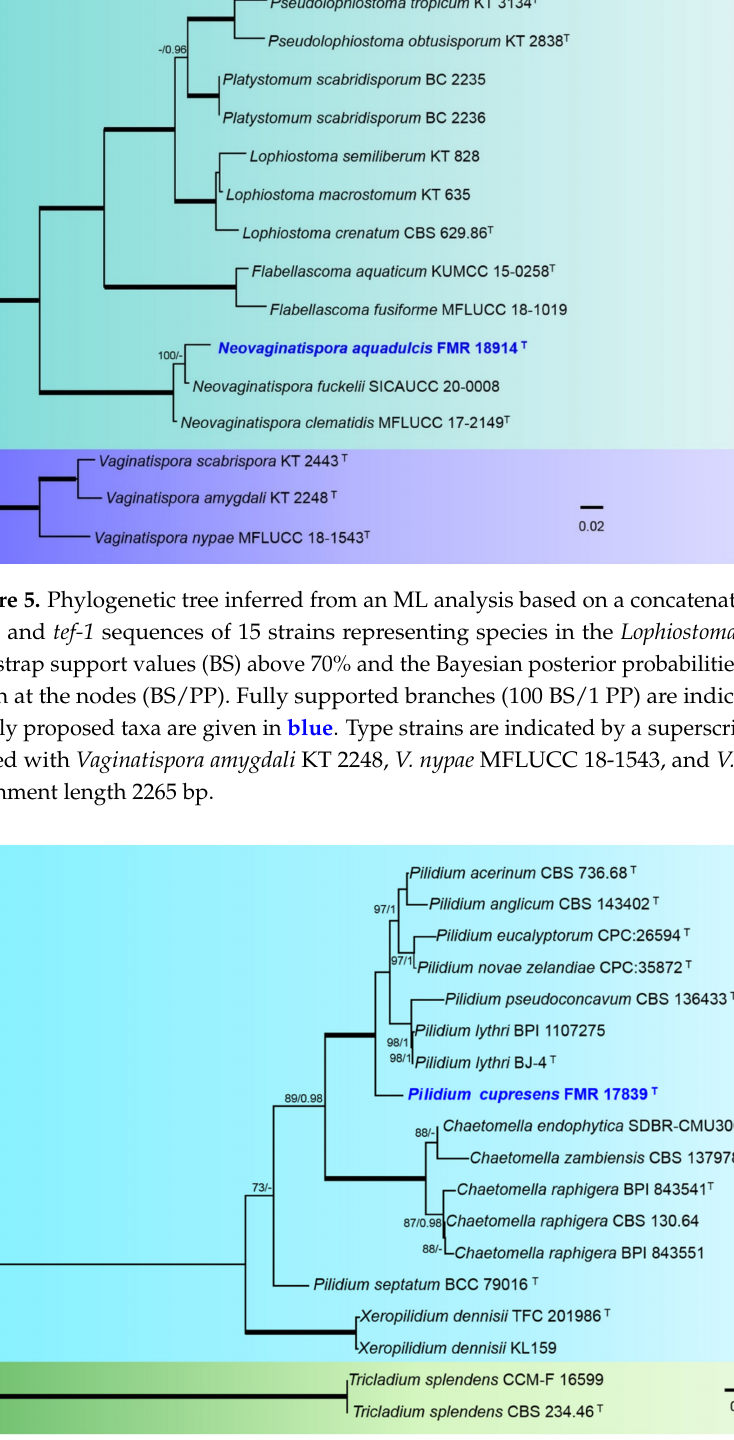
Figure 6. Phylogenetic tree inferred from an ML analysis based on a concatenated alignment of ITS, and LSU sequences of 18 strains representing species in the Chaetomellaceae . The RAxML bootstrap support values (BS) above 70% and the Bayesian posterior probabilities (PP) above 0.95 are given at the nodes (BS/PP). Fully supported branches (100 BS/1 PP) are indicated in thicker lines. Newly proposed taxa are given in blue . Type strains are indicated by a superscript “T”. The tree was rooted with Tricladium splendens CBS 234.46 and CCM-F 16599. Alignment length 1246